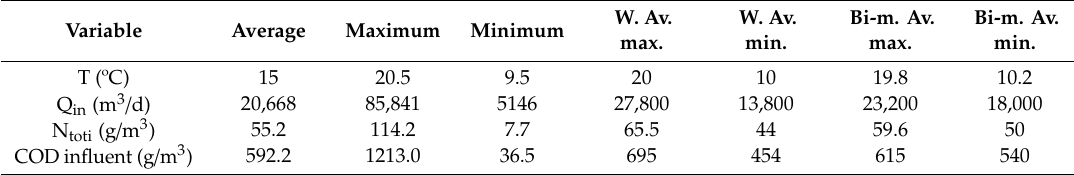
Figure 3. Weekly and bimonthly profile of influent temperature (°C), flow rate Q in (m 3 /d), total nitrogen concentration N tot concentration (g/m 3 ) and COD concentration (g/m 3 ). concentration N / m 3 ) and COD concentration (g / m 3 ). tot concentration (g Table 2. Characteristic values of the significant variables of the influent including weekly and